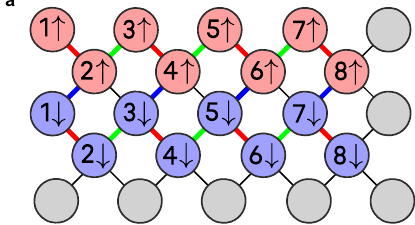
(FSWAP), red (onsite), blue (FSWAP), red (horiz+FSWAP), green (vert), red (FSWAP), green (vert). Vertical interaction parameters for 2×4 depend on the parity of the row index. Grey circles denote the unused qubits on the 23-qubit Rainbow chip.